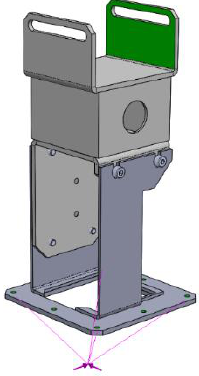
Figure 7. Accelerations application point.